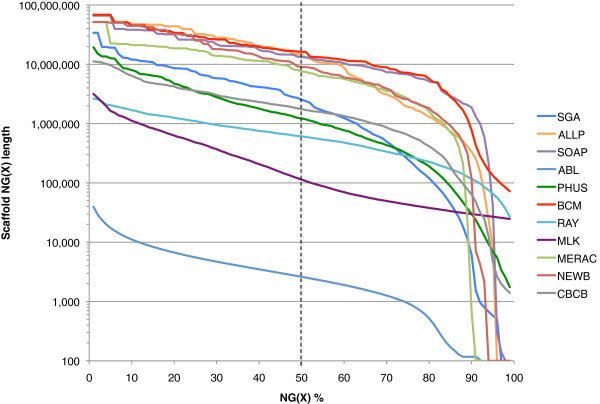
NG graph showing an overview of bird assembly scaffold lengths. The NG scaffold length (see text) is calculated at integer thresholds (1% to 100%) and the scaffold length (in bp) for that particular threshold is shown on the y-axis. The dotted vertical line indicates the NG50 scaffold length: if all scaffold lengths are summed from longest to the shortest, this is the length at which the sum length accounts for 50% of the estimated genome size. Y-axis is plotted on a log scale. Bird estimated genome size = ~1.2 Gbp.